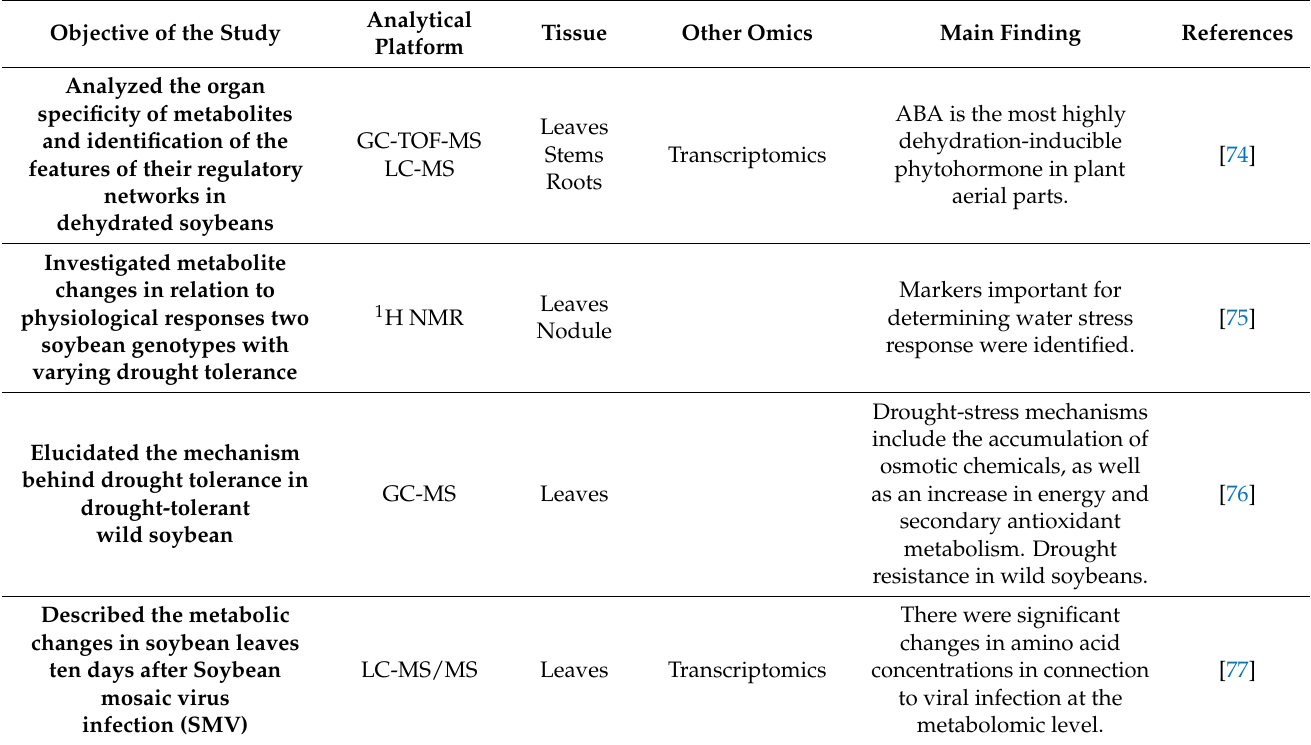
Table 1. Recent progress in soybean metabolomics studies for identification of key biomarkers to mitigate biotic and abiotic stress tolerance and other growth